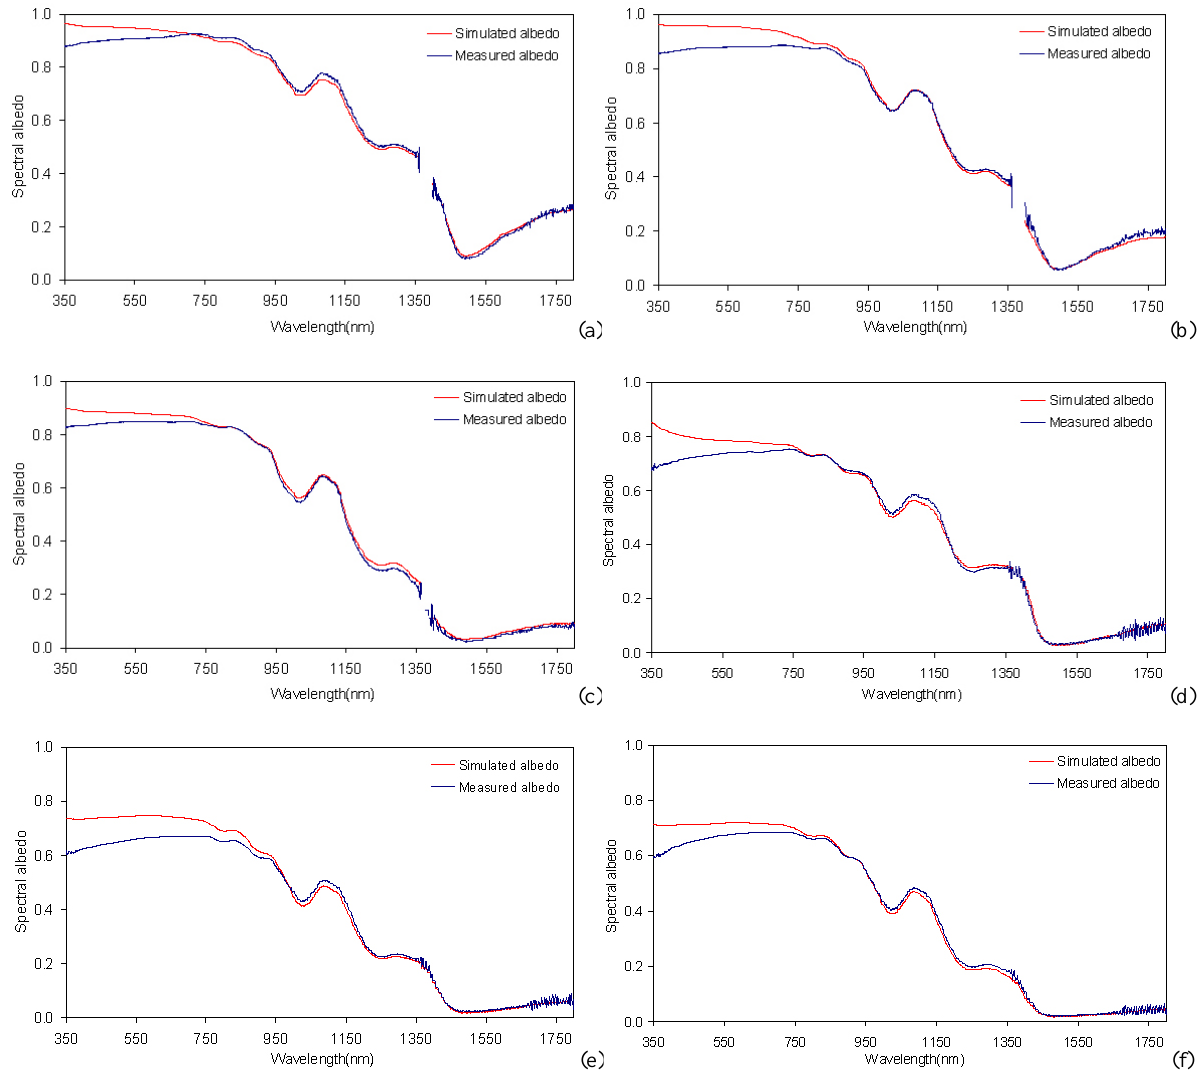
Fig. 5. The comparison between simulated plane albedo and field measured spectral albedo; (a–c) are for snow Type-I at 11:20, 11:50 and 12:20 local time, and (d–f) are for snow Type-II at 09:20, 11:00 and 12:00 local time, respectively.